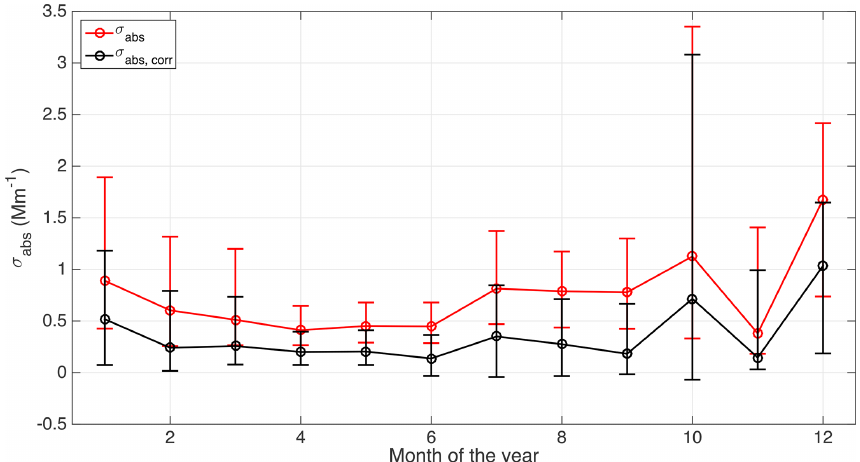
Figure 2. Monthly variation of the LAC values. Circles are median values. Error bars are 25th and 75th